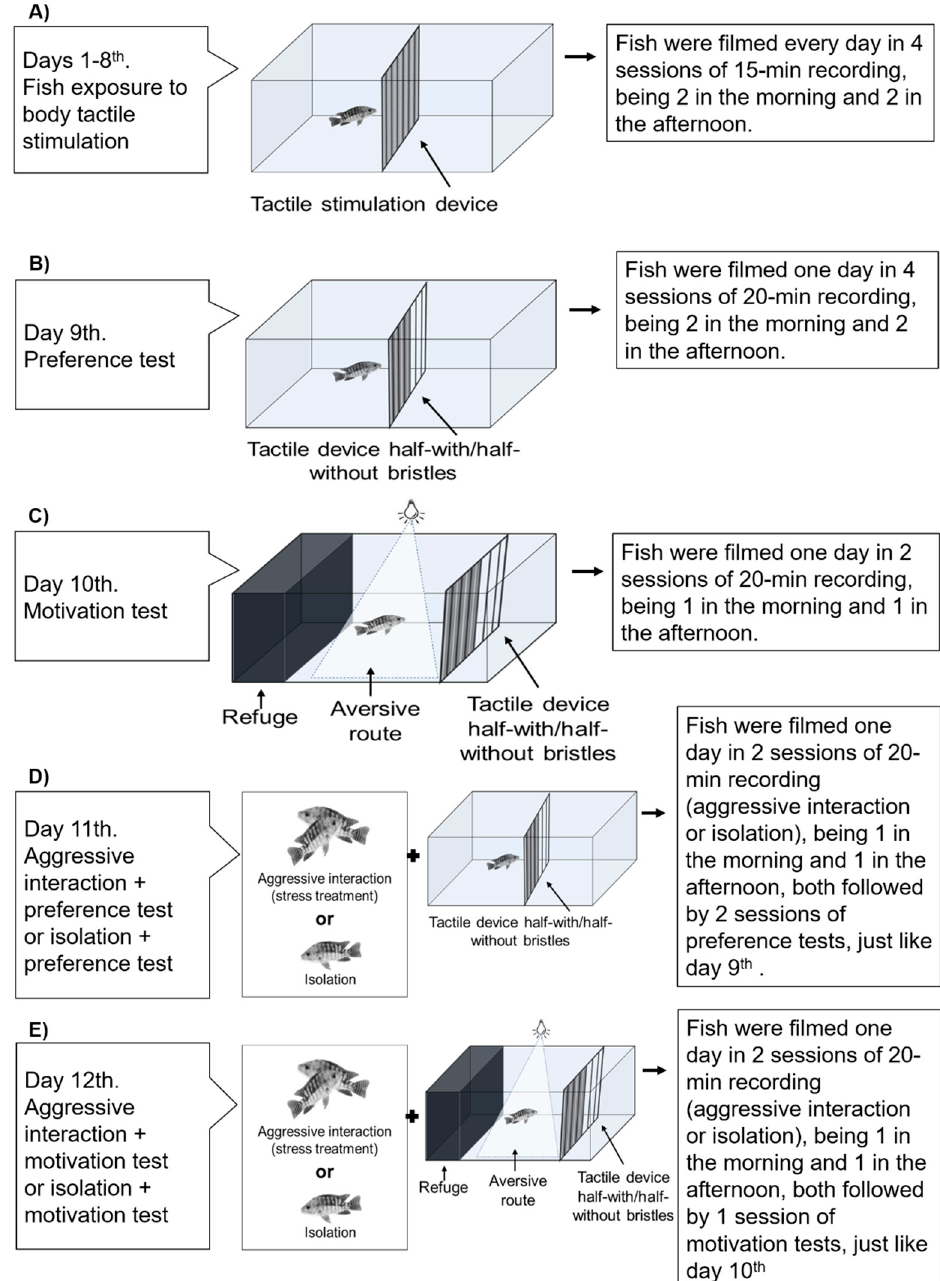
Figure 2. Protocol timeline. The steps of the experimental strategy showing the sequence of tests that fish were assigned to over 12 days. ( A ) Fish were isolated in glass aquaria and exposed to tactile stimulation for 8 days. ( B ) Preference test wherein half of the sticks in the apparatus had the bristles removed to allow spontaneous choices between tactile or no tactile stimulation. ( C ) Motivation test, in which fish had to leave a refuge (dark plastic cover) and surpass an aversive route (light path) to reach the tactile apparatus. ( D ) Fish were randomly paired and exposed to social stress (aggressive interaction) or isolation in another aquarium as a control for handling; they were, then, tested for preference, exactly as on the 9th day. ( E ) Fish were paired again as in the previous day and, then, tested for motivation, exactly as on the 10th day. The way animals were recorded is shown in each